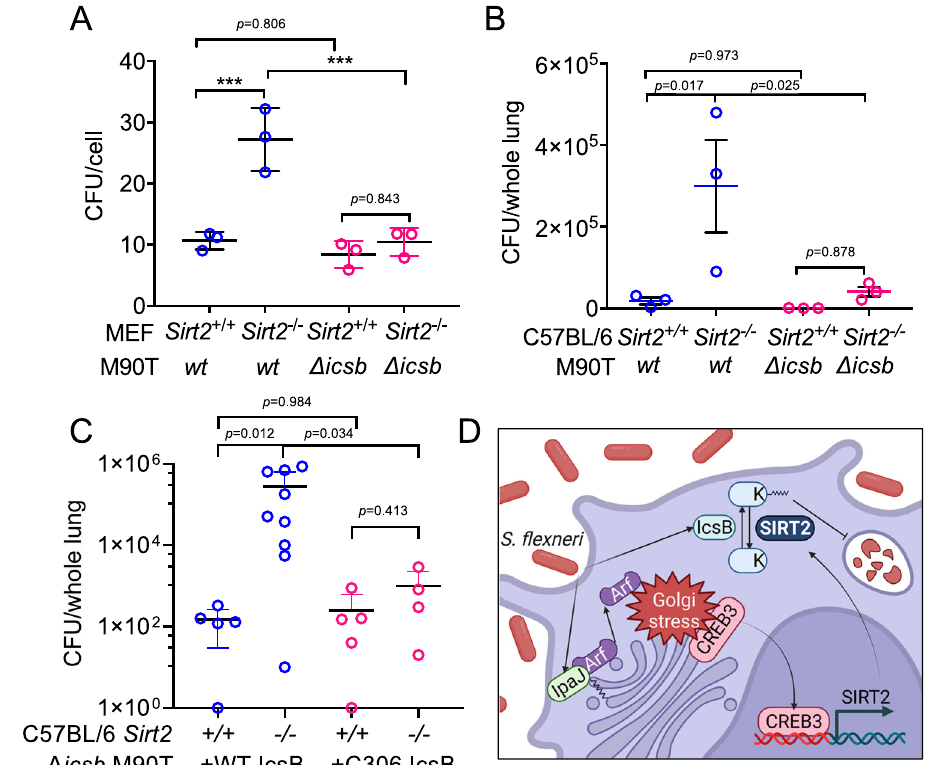
Fig. 8 | SIRT2 restricts Shigella infection in cell and in vivo by counteracting IcsB. A Effect of SIRT2 knockout and IcsB deletion on S. fl exneri intracellular proliferation. MOI were determined after 10min of infection and 6 h of incubation in the presence of 50 μ g/ml gentamicin. Data are represented as mean ± SEM with three biological replicates. Statistical evaluation was done by two-way ANOVA. B CFU in lung homogenates from Sirt2 +/+ and Sirt2 − / − C57BL/6 J mice infected with wildtype or IcsB deletion S. fl exneri M90T for 3 days. Data are presented as mean ± SEM with three mice per